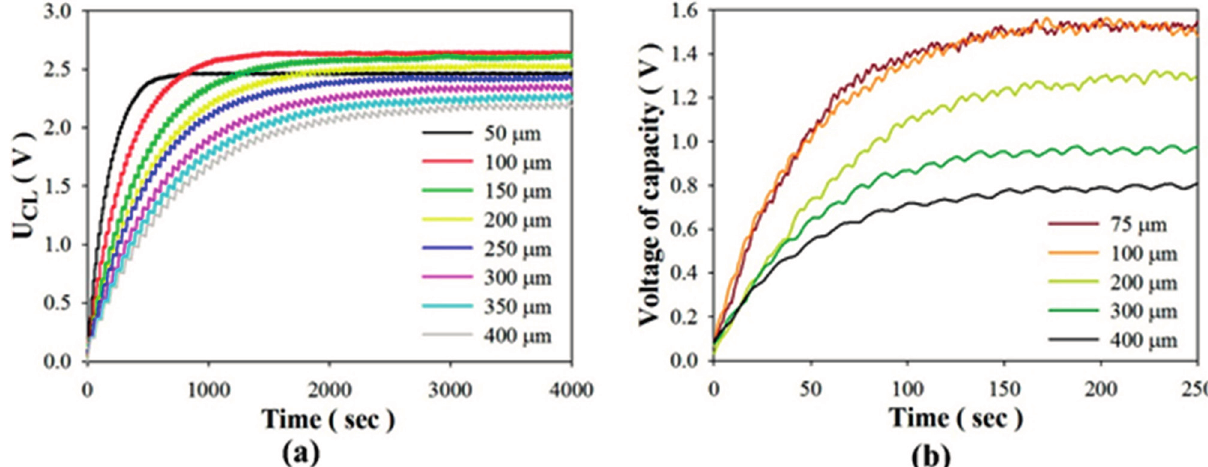
Figure 12. Relationships between the stored voltage and time when using PZT cells with various thicknesses, respectively, at the optimal period, as determined in the simulated calculation ( a ); and the experiment ( b